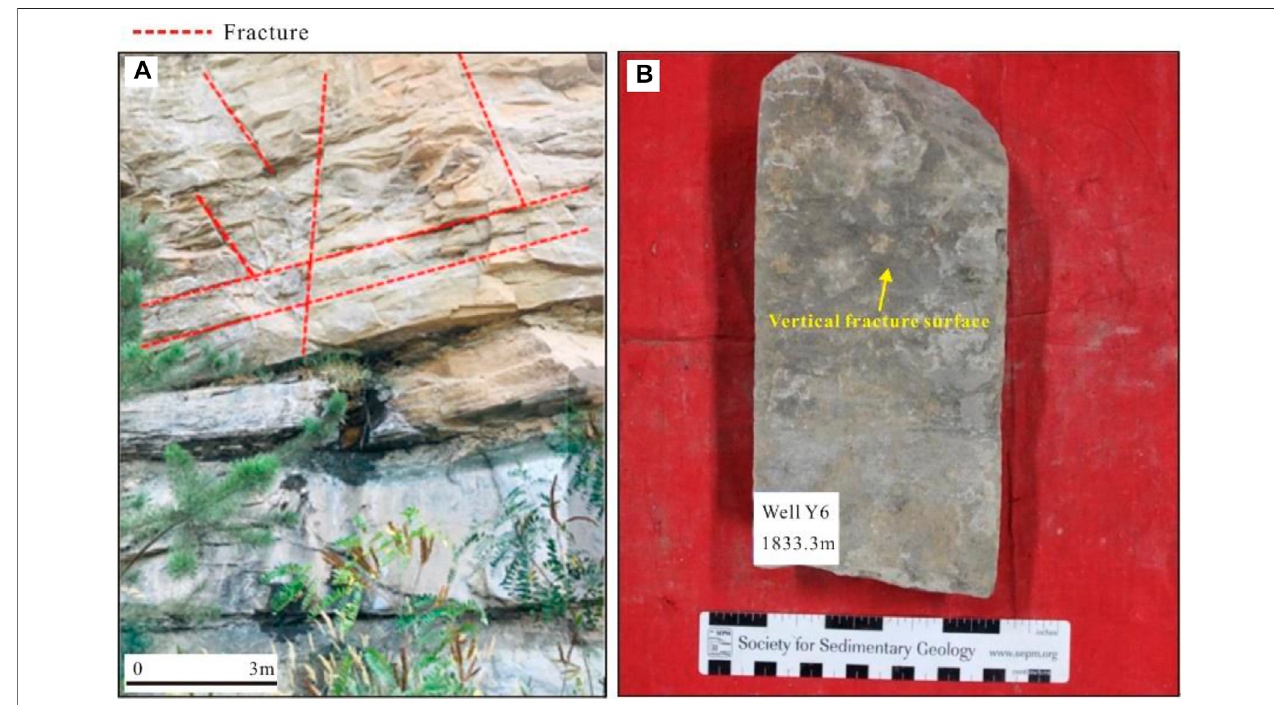
FIGURE4| DevelopmentcharacteristicsoffracturesintheYanchangFormationsandstoneinthestudyarea. (A) YanhePro fi le,Chang6Memberoutcrop; (B) High angle fracture, Well Y6, Chang 6 Member, 1,833.3 m.